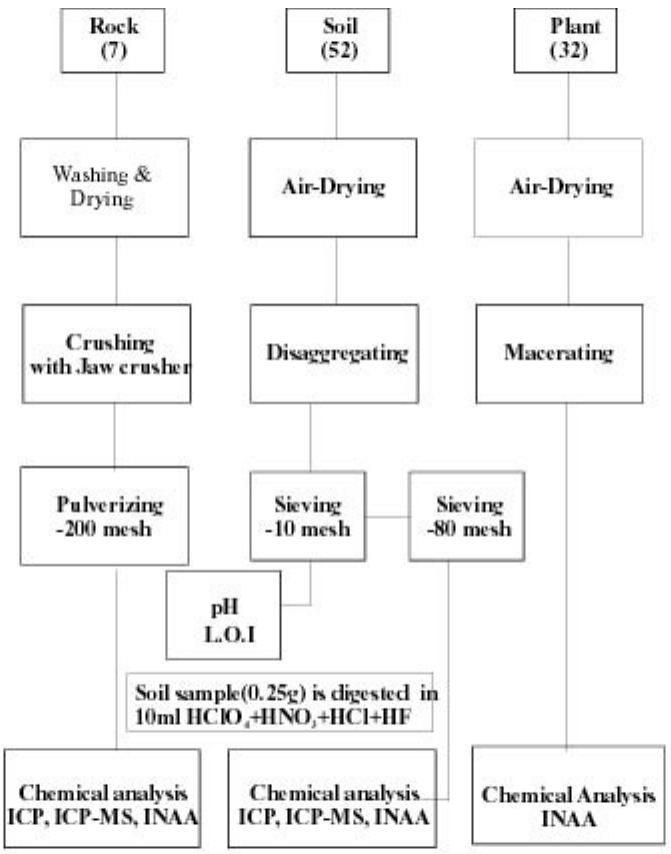
FIGURE 2. Flow chart showing the procedure of sample preparation and chemical analysis (figures in parenthesis are the number of